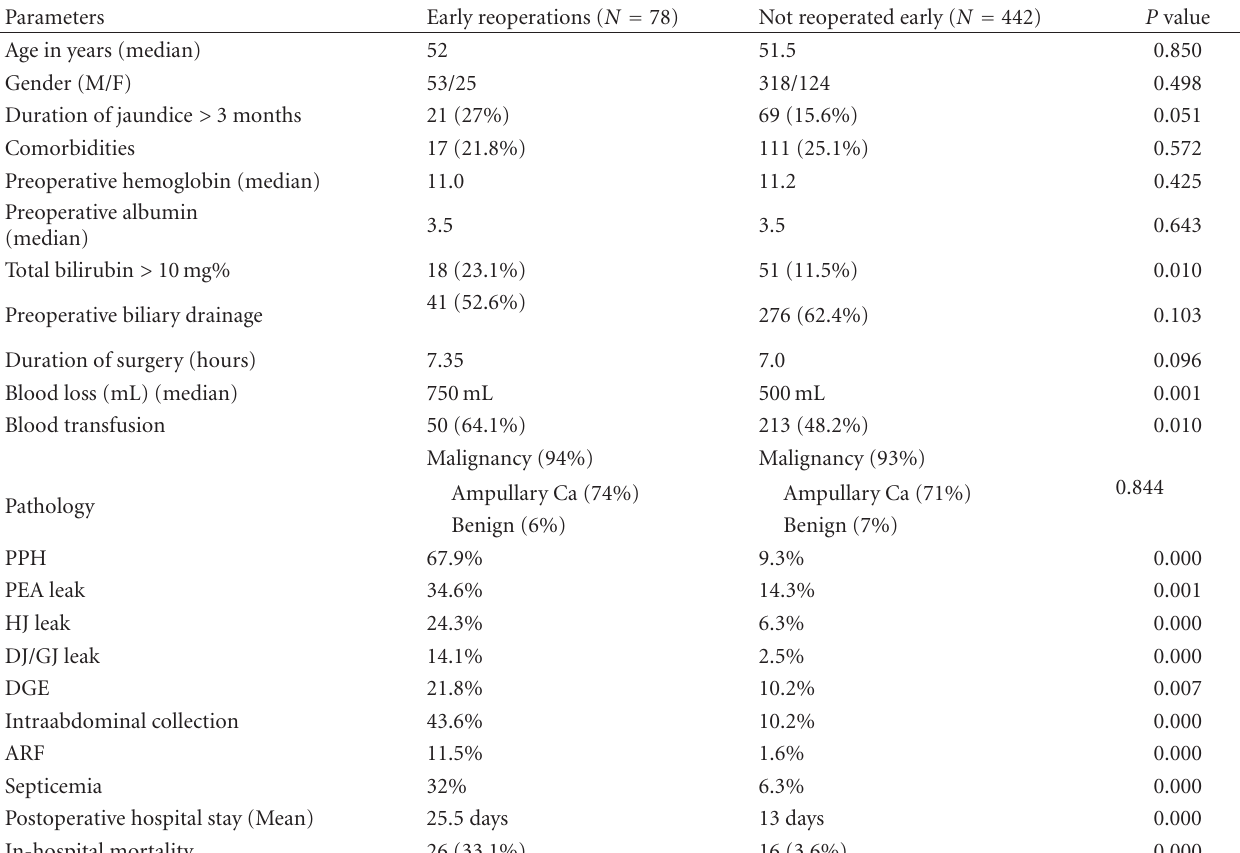
Table 2: Univariate analysis of factors predicting the need for early reoperation.